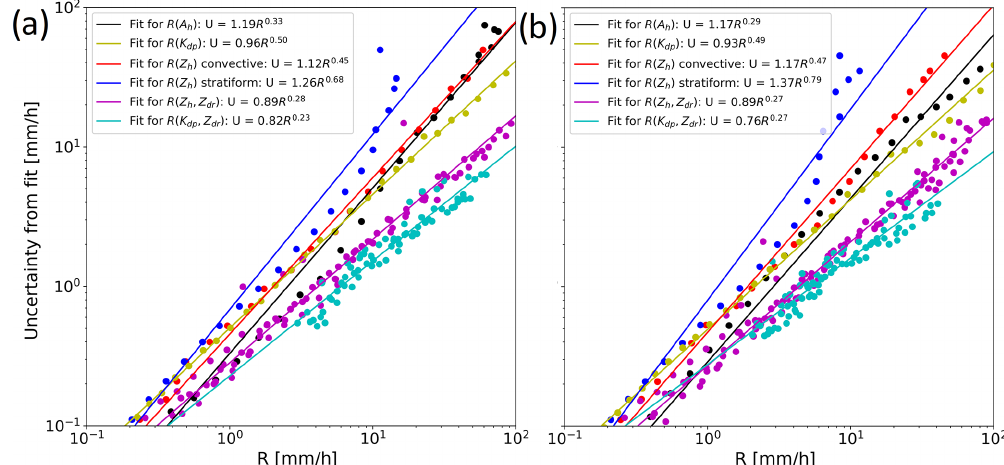
Figure 5. The parametric uncertainty of R estimated using the methodology of Kirstetter et al. (2015) as a function of mean R for given ranges of radar moments at the C-band (a) and X-band (b)